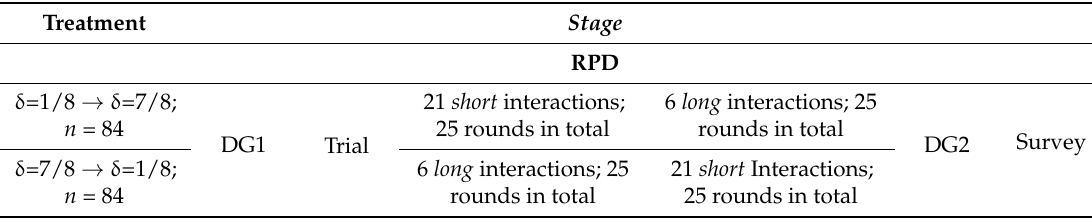
Table 2. Timeline and experimental design.